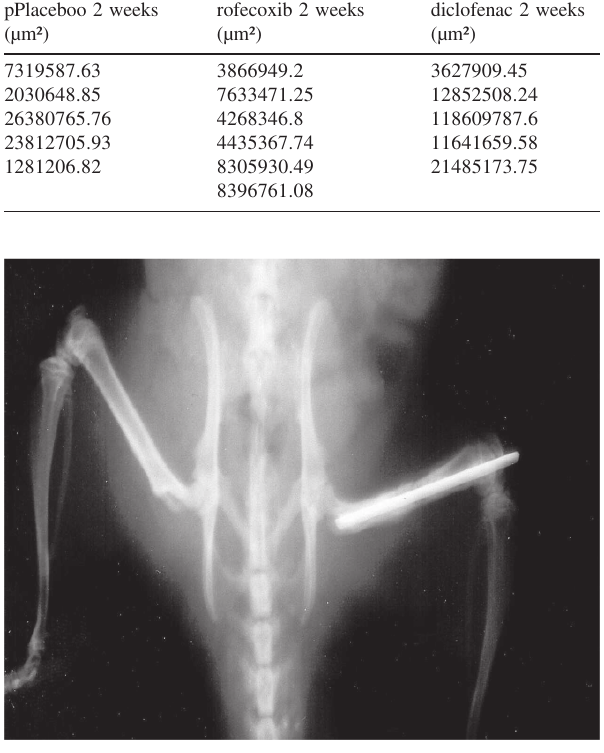
Figure 7 - Radiographic image of femur